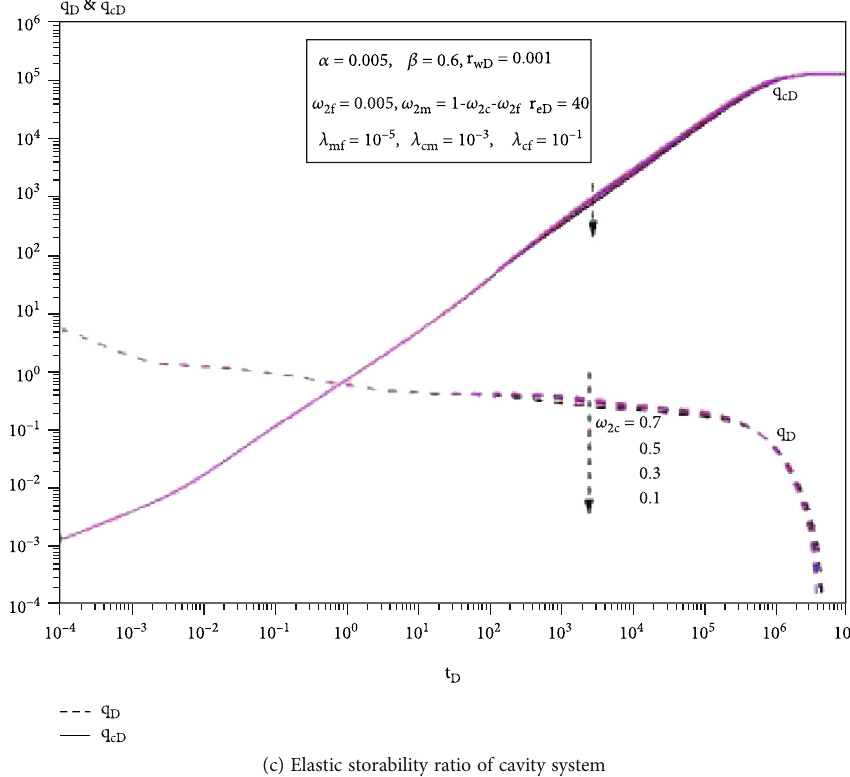
Figure 8: In fl uence of elastic storability ratios of triple media on the production of an AFVW in a pore-cavity-fracture carbonate